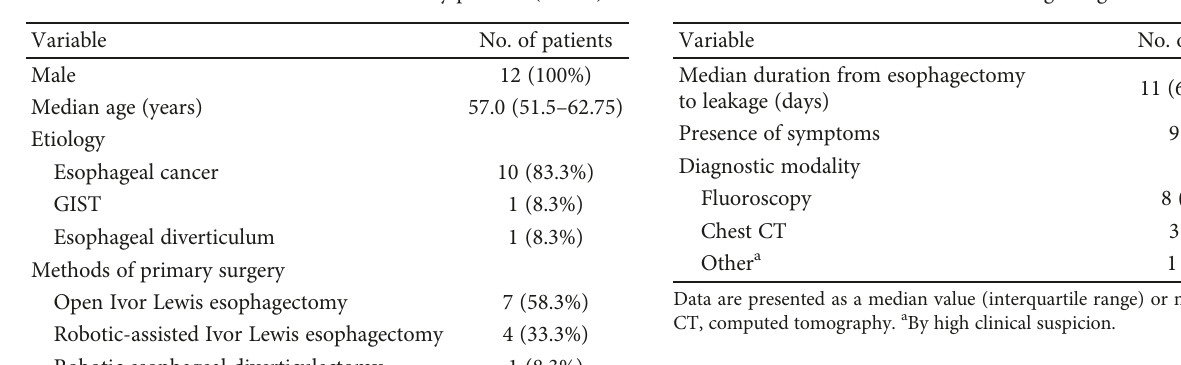
Table 2: Anastomotic leakage